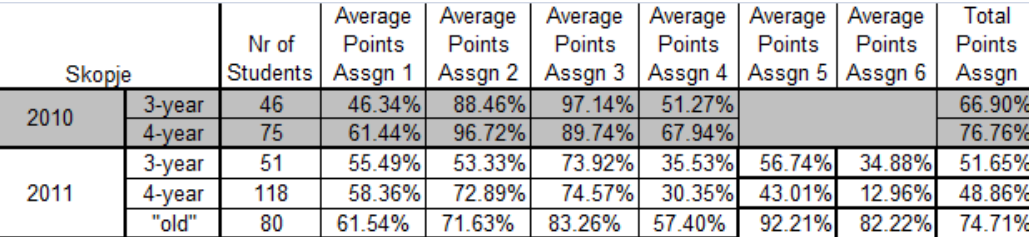
Assignment Points for Students from